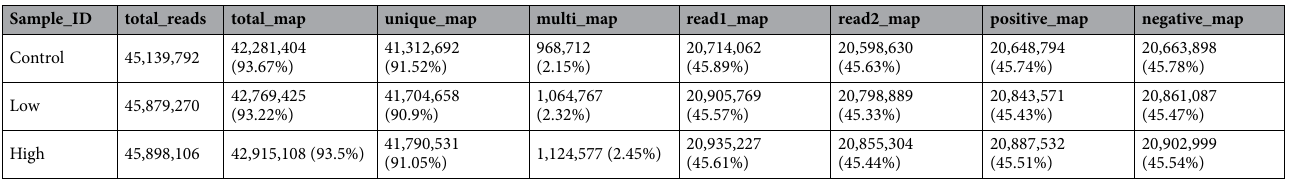
Table 1. Statistical tables of mapped reads of paired-end. total_reads: The number of clean reads sequencing data after quality control. total_map: The number and percentage of clean reads compared to the reference genome unique_map: The number and percentage of reads at unique locations compared to the reference genome. multi_map: The number and percentage of reads at multiple locations compared to the reference genome. read1_map: The number and percentage of read1 compared to the reference genome. read2_map: The number and percentage of read1 compared to the reference genome. positive_map: The number and percentage of reads on the positive chain compared to the reference genome. negative_map: The number and percentage of reads on the negative chain compared to the reference genome.